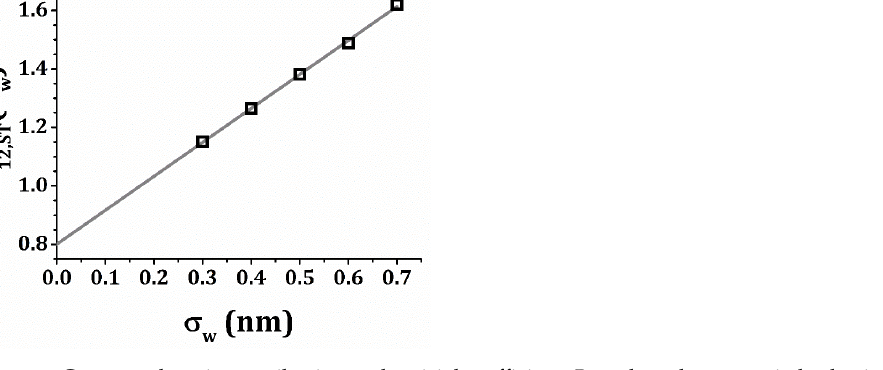
Figure 1. Computed steric contribution to the virial coefficient, B 12 , plotted vs. protein hydration layer thickness, σ w . The points are computed data; the line serves as a visual guide for the extrapolation.